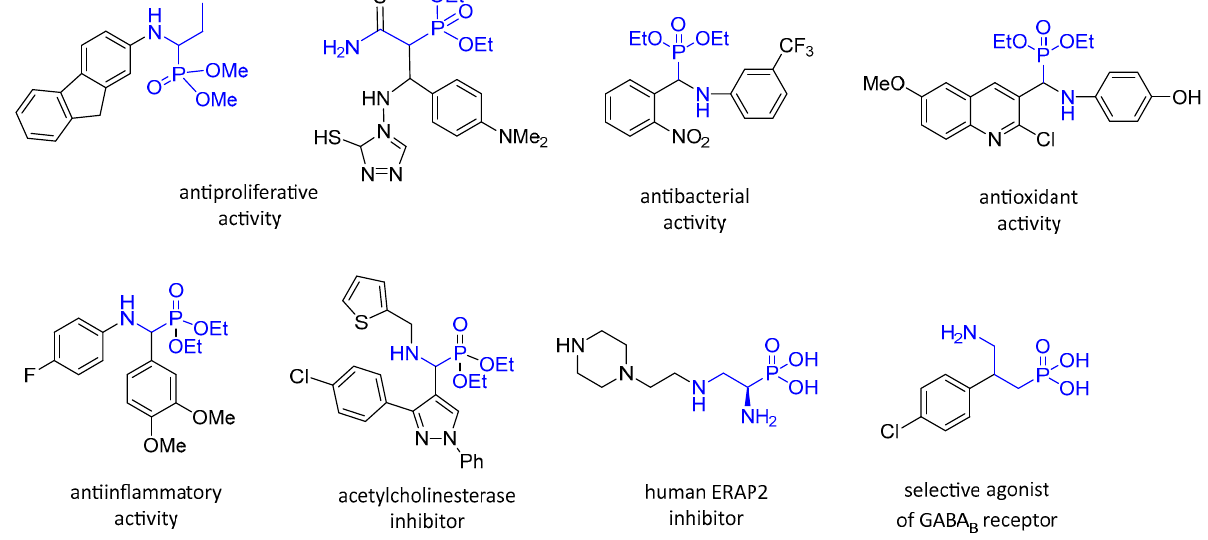
Figure 4. Examples of biologically active aminophosphonates.